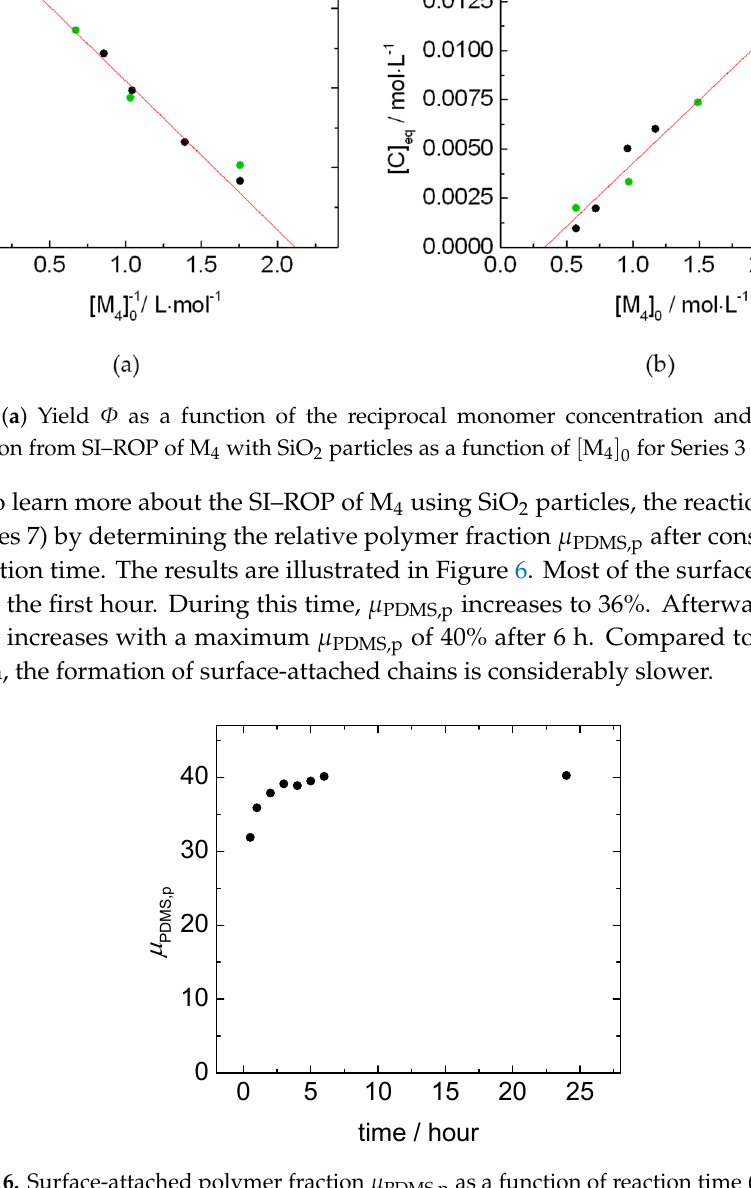
Figure 6. Surface-attached polymer fraction µ PDMS,p as a function of reaction time (Series 7).